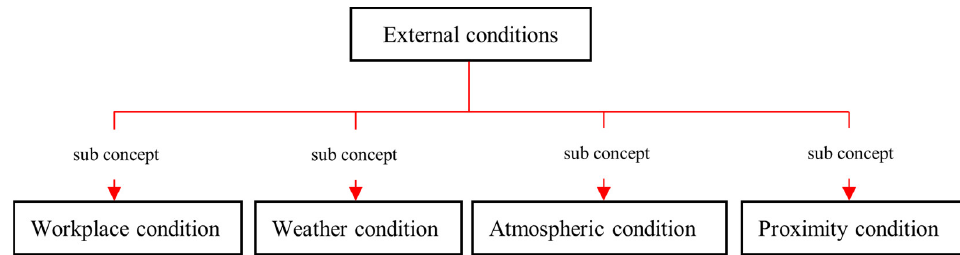
Figure 5. The sub-concepts of external conditions.